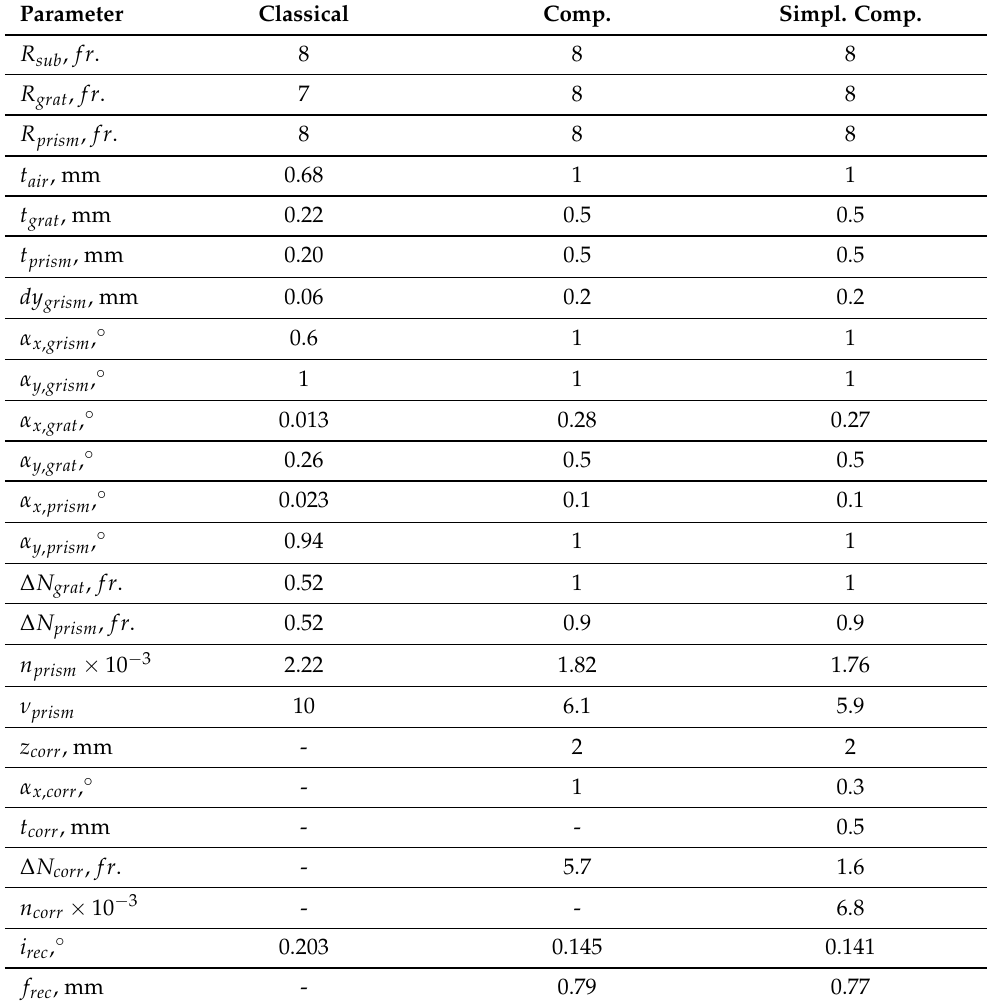
Table 3. Tolerances based on the image quality criterion.